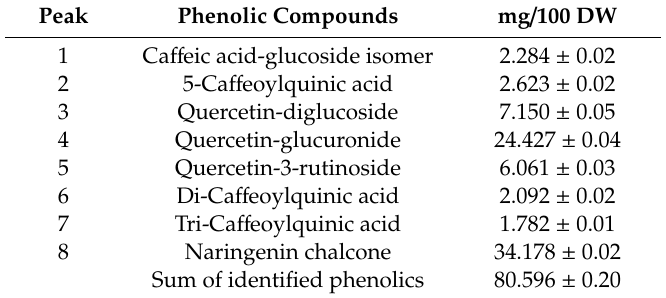
Table 3. Individual phenolic compounds content of TBE, expressed in mg / 100 g DW (equivalents of chlorogenic acid and